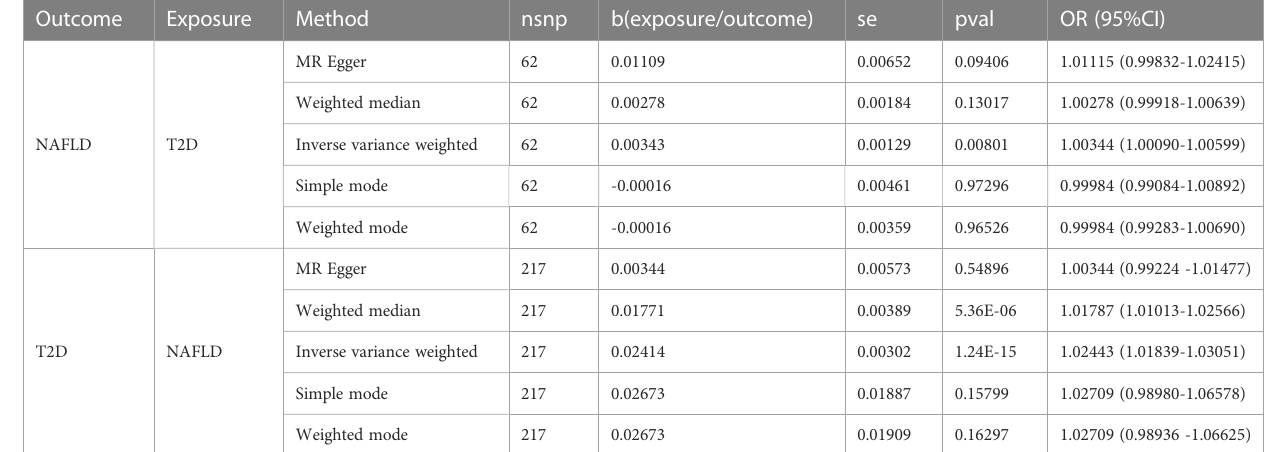
TABLE 4 Results of two-sample MR analysis of NAFLD and